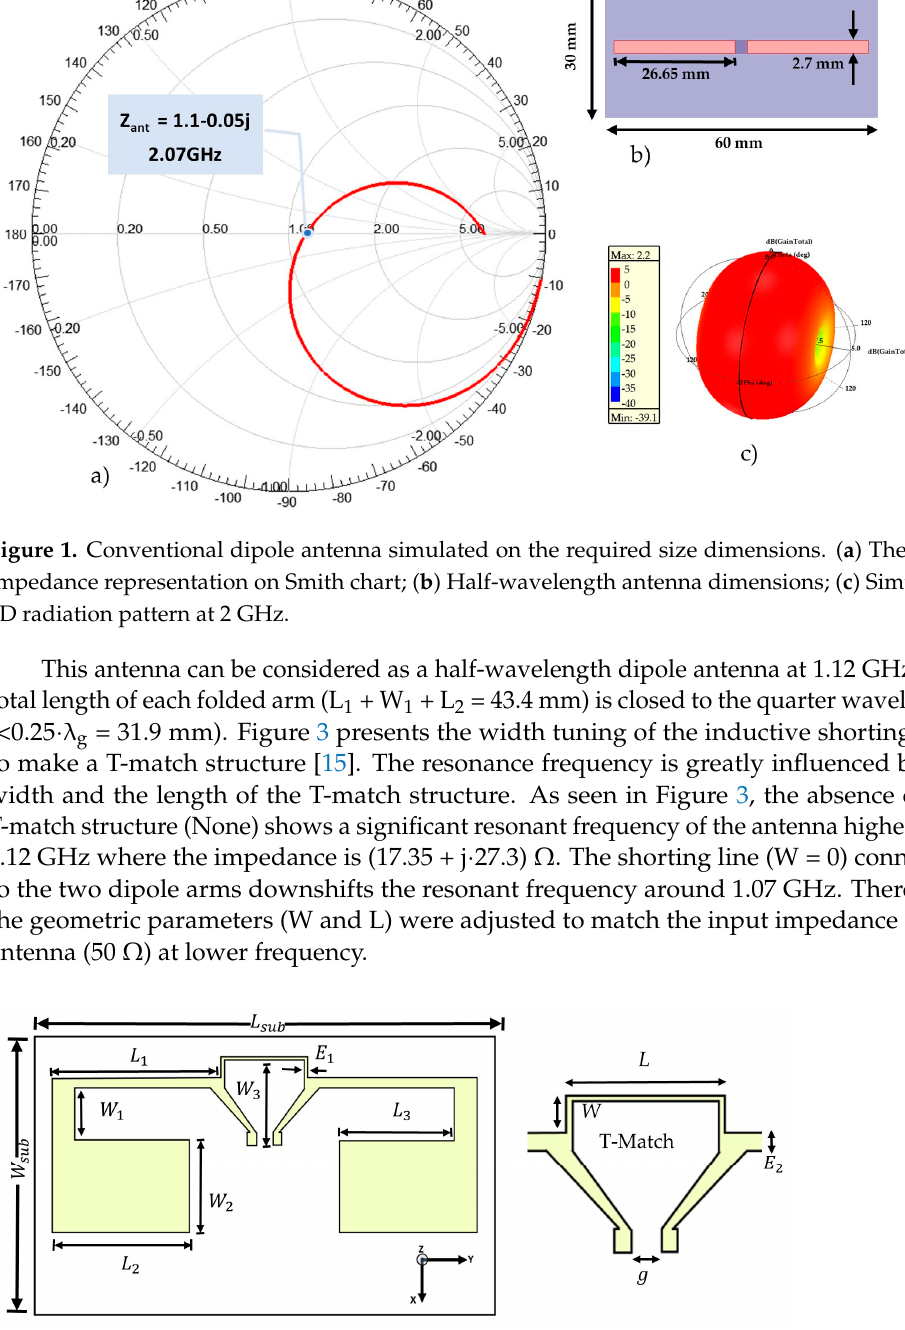
Figure 2. Detailed geometry of the compact, T-match dipole antenna on an FR4 substrate ( L sub = 56 mm, W sub = 32 mm, L 1 = 20.65 mm, W 1 = 5.95 mm, L 2 = 16.8 mm, W 2 = 10.5 mm, L 3 = 14 mm, W 3 = 9.625 mm, E 1 = 0.35 mm, E 2 = 1.05 mm, g = 2.03 mm).